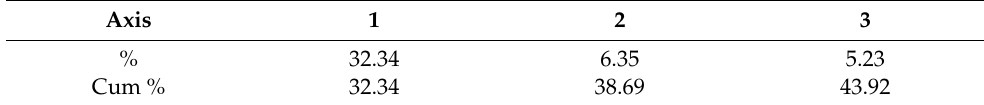
Figure 3. Principal coordinates analysis (PCoA) calculated from the pooled data of twenty-six inter-primer binding site (iPBS) primers in 45 bean varieties. Table 7. PCoA analysis of bean varieties.